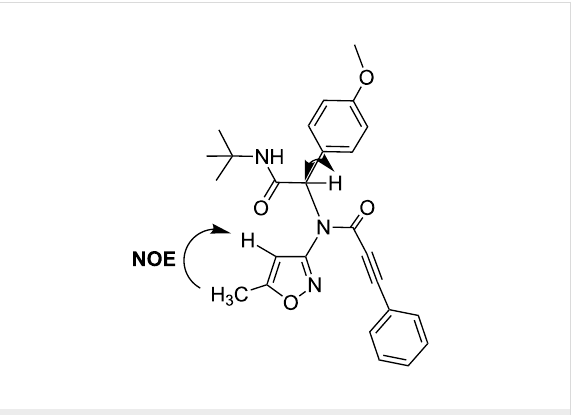
Figure 4: Selected data of NOE and HSQC experiments for com- pound 9d .